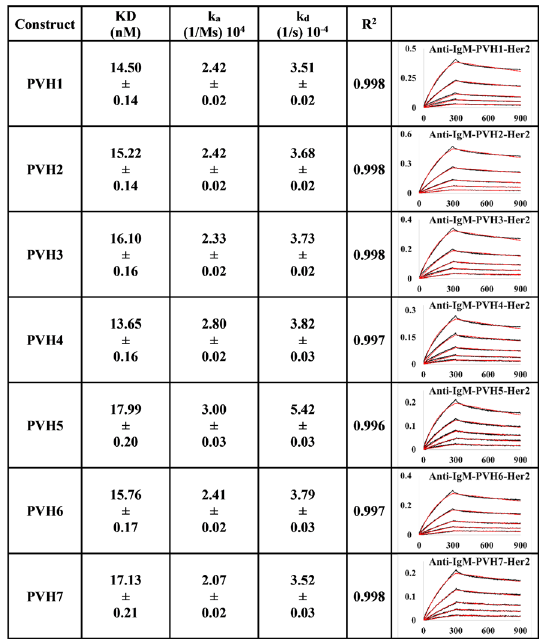
Figure 4. BLI measurement of trastuzumab IgM variants (HVH1-7) interacting with Her2 using Anti-IgM bound on SA biosensor to capture the Fc region of IgM. KD, k , k , and R 2 and fitting curves are shown according to the 1:1 fitting model. The x-axis a d and y-axis of the graph represent the time (s) and response (nM), respectively. All values were rounded off to 2 decimal places. Triplicate experiments were performed, and standard errors are shown